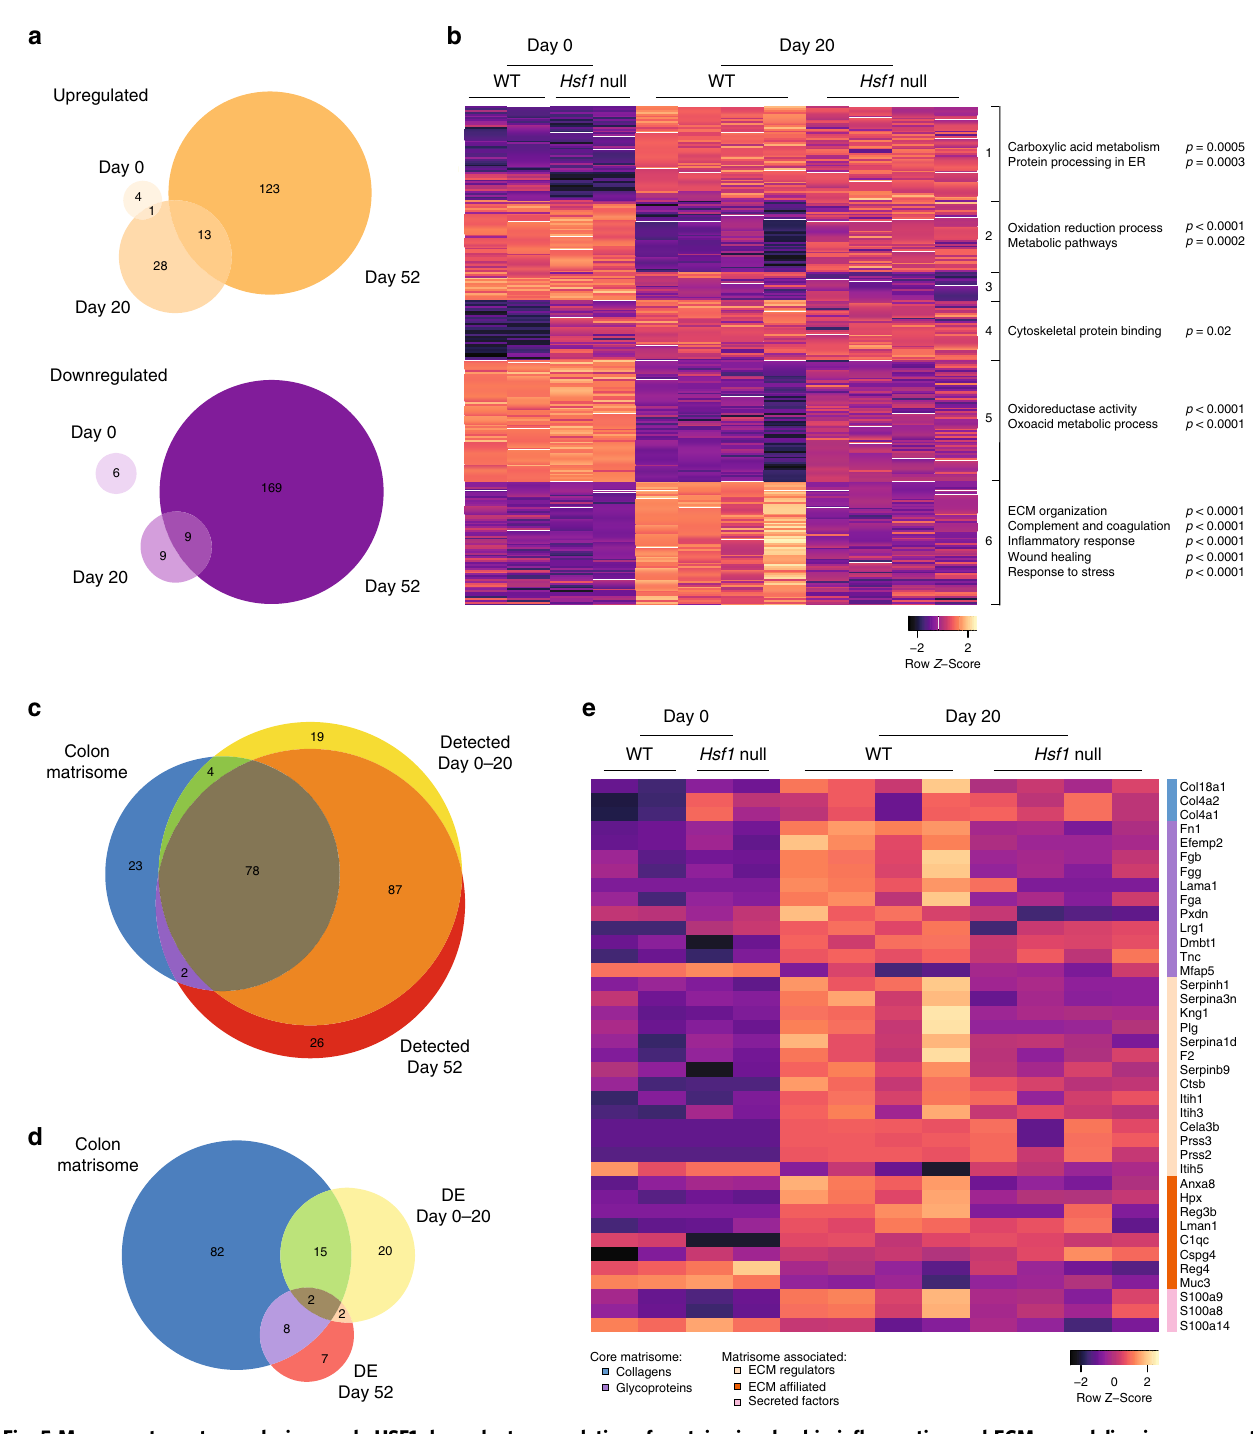
Fig. 5 Mass spectrometry analysis reveals HSF1-dependent upregulation of proteins involved in in fl ammation and ECM remodeling in response to AOM-DSS. Colons from non-treated (day 0) mice, or from mice treated with AOM-DSS for 20 or 52 days were analyzed by LC – MS/MS. a Venn-diagrams representing overlap between differentially expressed proteins upregulated (upper panel) and downregulated (lower panel) in WT vs. Hsf1 null colons at different time points of the AOM-DSS treatment. b Heatmap of standardized mass spectrometry values of differentially expressed (DE) proteins (FC > 1.5; FDR < 0.1) between day 0 and day 20 WT and Hsf1 null colons, clustered using K -means partition clustering into six clusters. Pathway analysis was performed using gPro fi ler and selected signi fi cant pathways are shown. See also Supplementary Data 3, 4. c , d Venn-diagrams representing overlap between the mouse colon matrisome and the matrisome proteins detected c and DE d in our mass spectrometry analysis. e Heatmap of standardized mass spectrometry values of DE matrisome proteins (FC > 1.5; FDR < 0.1) between day 0 and day 20 WT and Hsf1 null colons, clustered by af fi liation to core matrisome and matrisome-associated